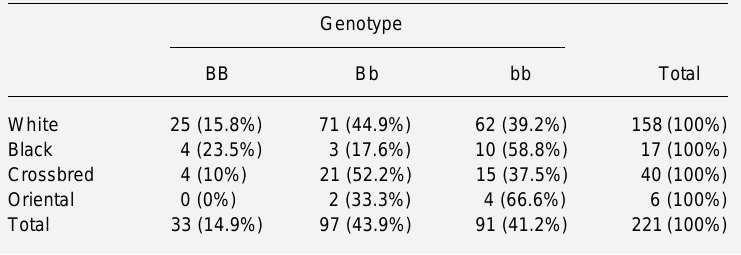
Table 1 - VDR genotype distribution among different races in the groups of young individuals, elderly subjects without fractures and elderly subjects with fractures.